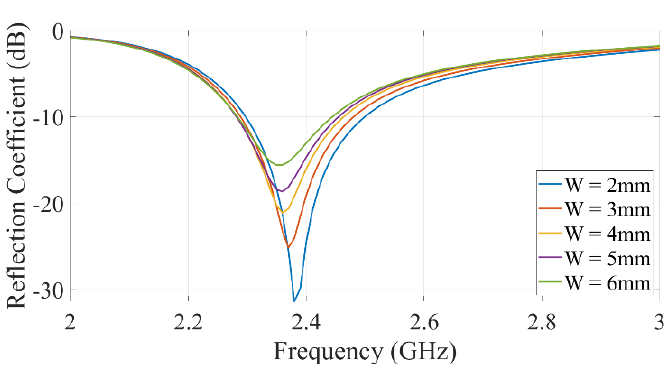
Figure 4. Simulated reflection coefficient of the proposed PIFA design for different notch widths.